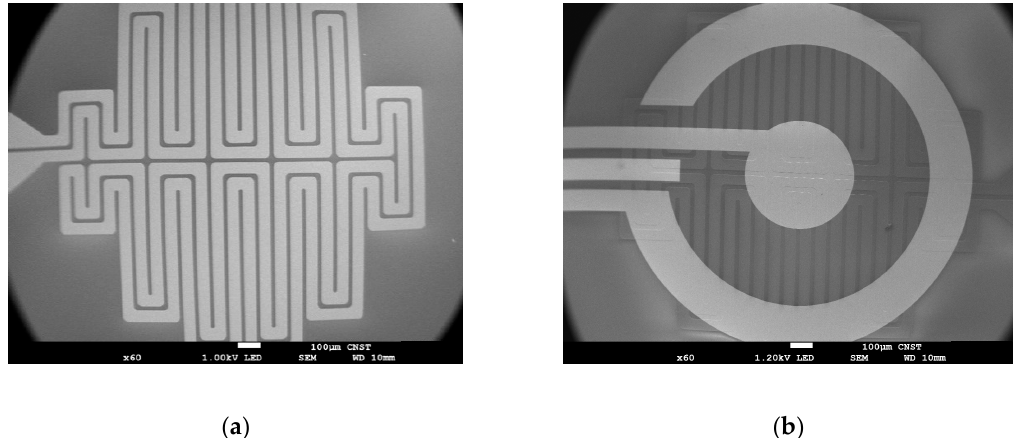
Figure 3. Scanning electron micrograph (SEM) of the embedded microheater: before electrodes were patterned on top ( a ); and after the fabrication was complete ( b